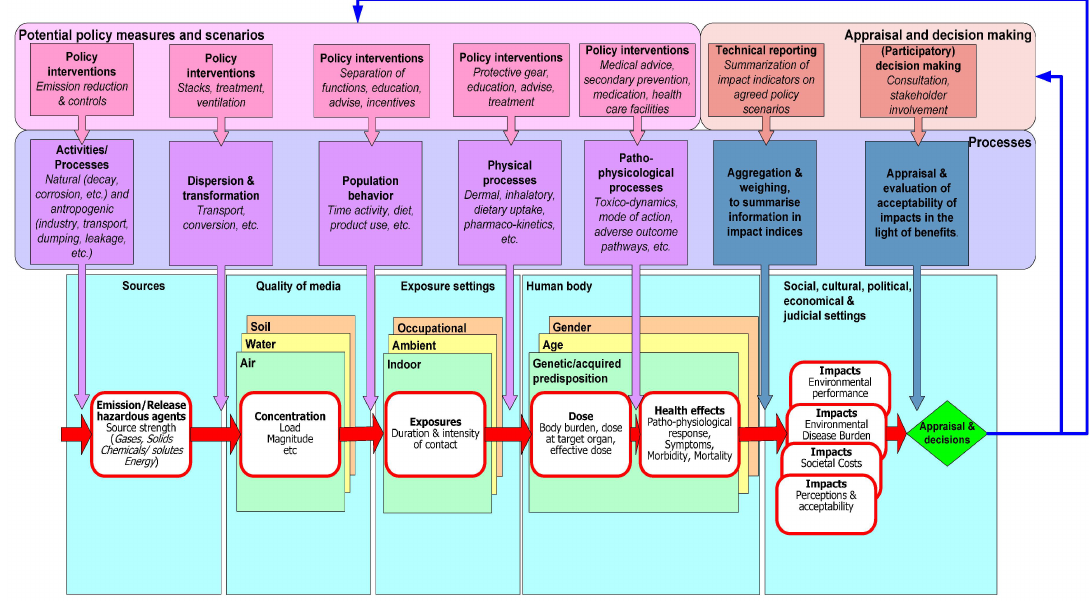
Figure 5. Causal chain, governing physical, chemical and biological processes and evaluation of acceptability of relevant impacts in relation to intervention options within the legal, social, economic, and cultural